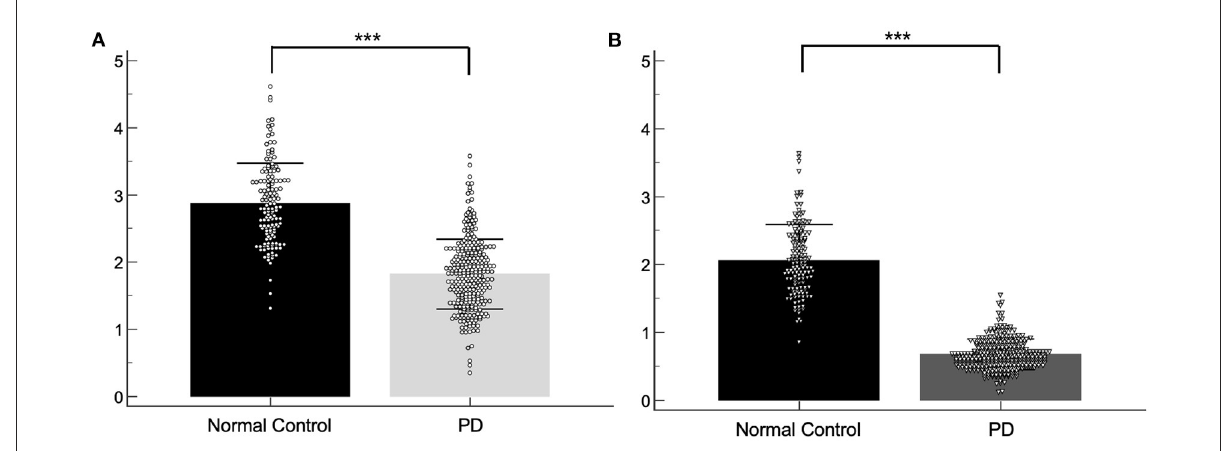
FIGURE1 Scatter plots of the baseline SBRs for the normal control and PD group. SBRs of the caudate (A) and putamen (B) . *** p < 0.001.